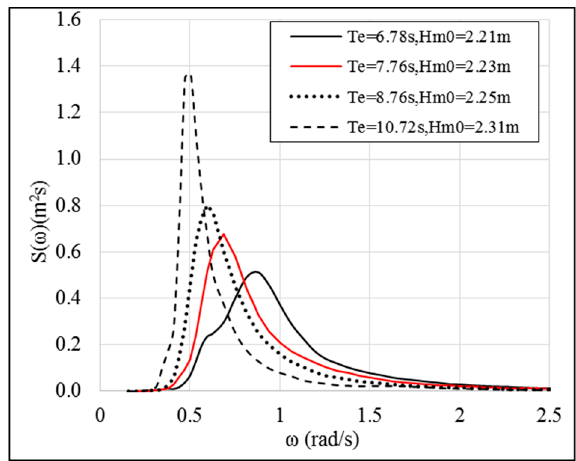
Figure 10. Average measured wave spectrum for 4 different average periods ( H m 0 ≈ 2.25 m).